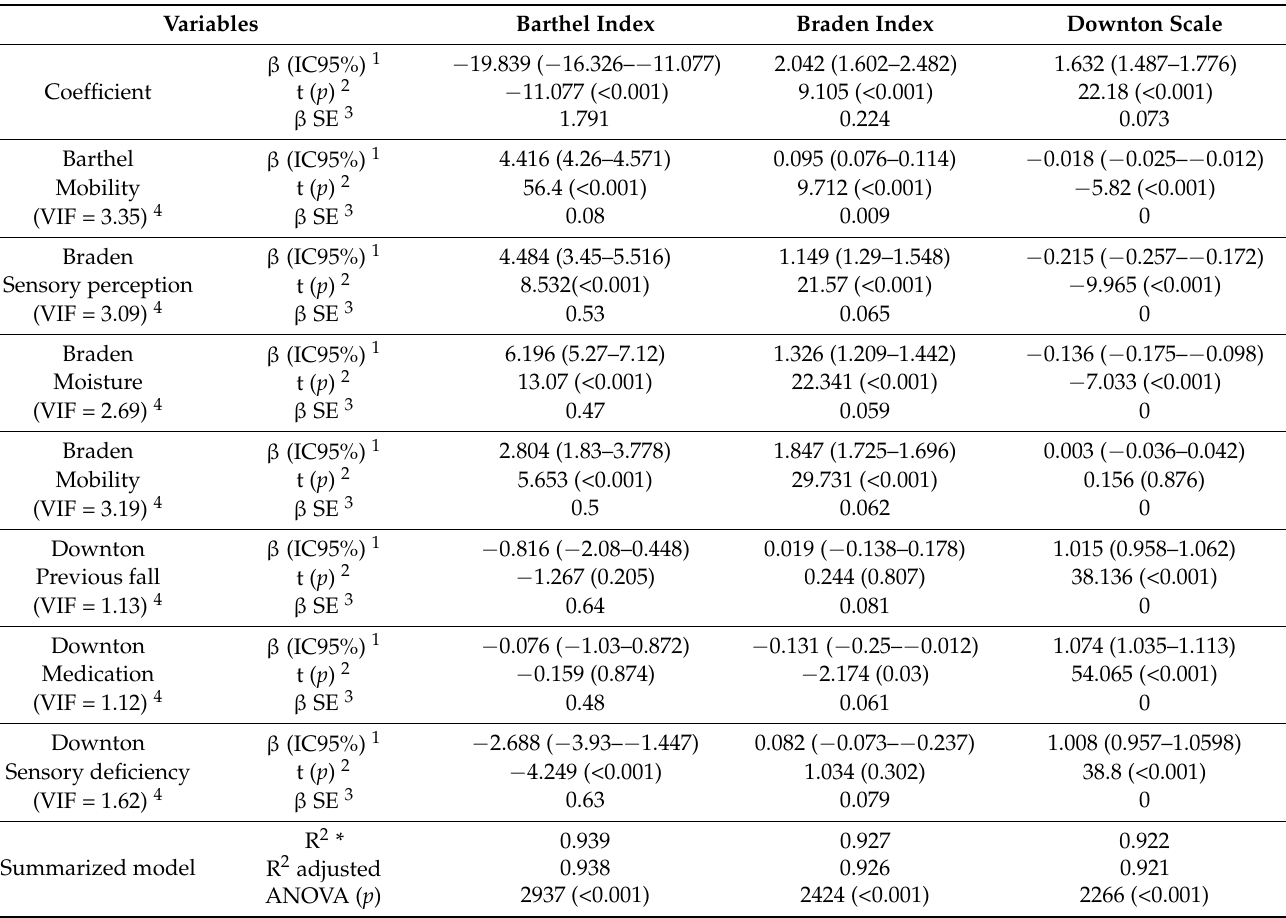
Table 3. Multiple linear regressions